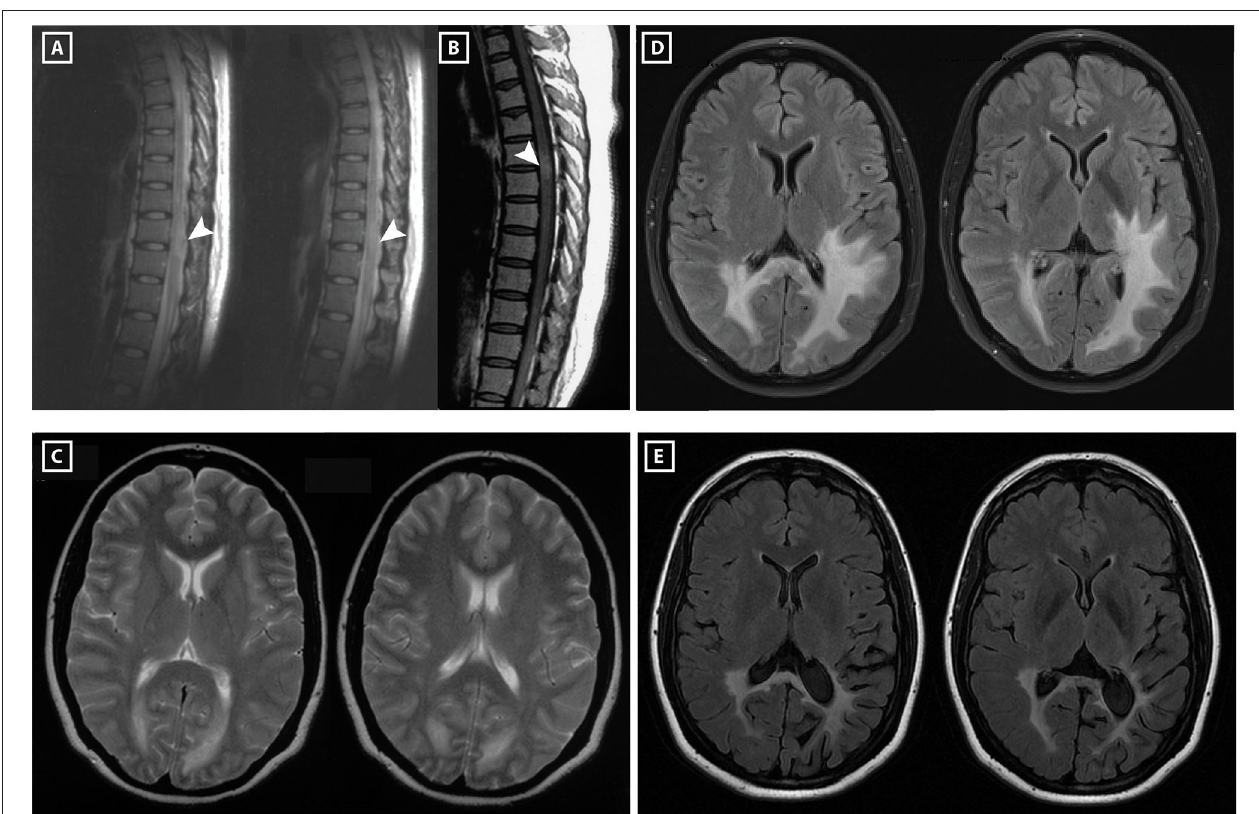
FIGURE 1 | Spinal cord and brain MRI of the patient. In 2003, MRI of the spinal cord showed a hyper-intense lesion at T9–T11 levels (A) , and gadolinium-enhanced T1-weighted MRI showed a hyper-intense lesion at T4–T5 levels (B) . Her brain MRI revealed periependymal lesions around occipital horns of lateral ventricles (C) . In 2009, brain MRI showed T2 hyper-intense lesions around occipital horns of both lateral ventricles extending into left temporal and occipital lobes, right occipital lobe and splenium of the corpus callosum (D) . In 2017, brain MRI showed the white matter lesion reduced in size compared to the MRI performed in 2009 (E)